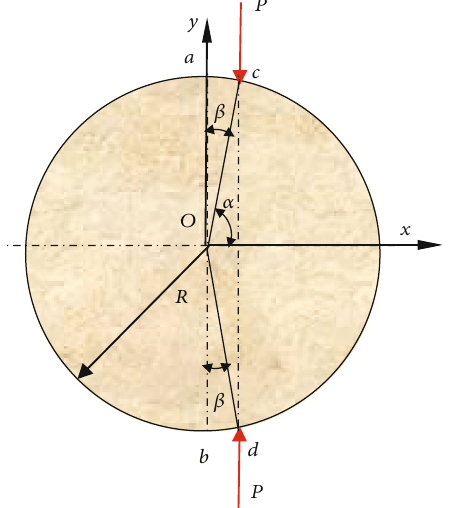
Figure 4: Mechanical model of compressed